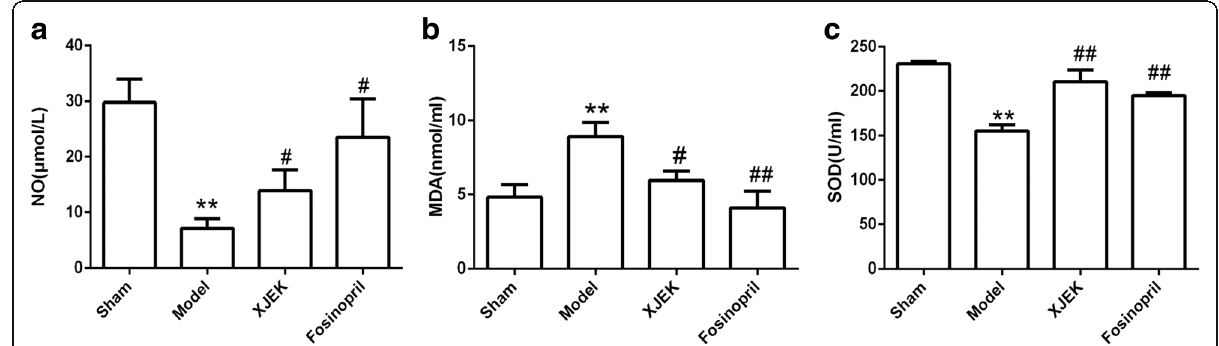
Fig. 6 Effect of XJEK on NO content ( a ), MDA content ( b ) and SOD content ( c ) in serum of MI mice (mean ± SEM, n = 6 – 9). * P < 0.05, ** P < 0.01 vs. Sham group; # P < 0.05, ## P < 0.01 vs. Model